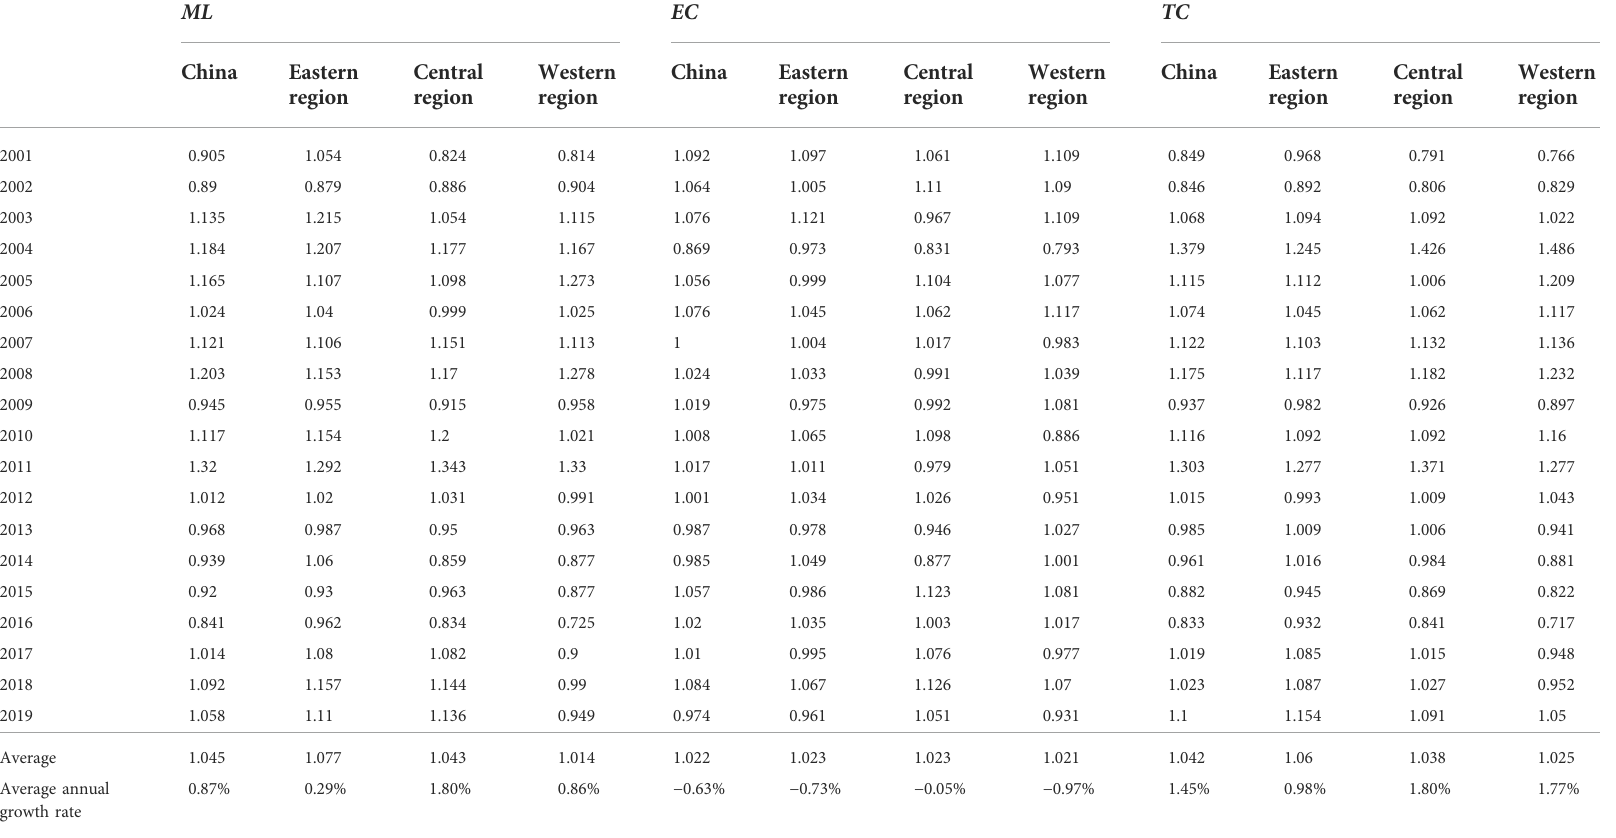
TABLE 2 Estimation results of the DCEEIE in